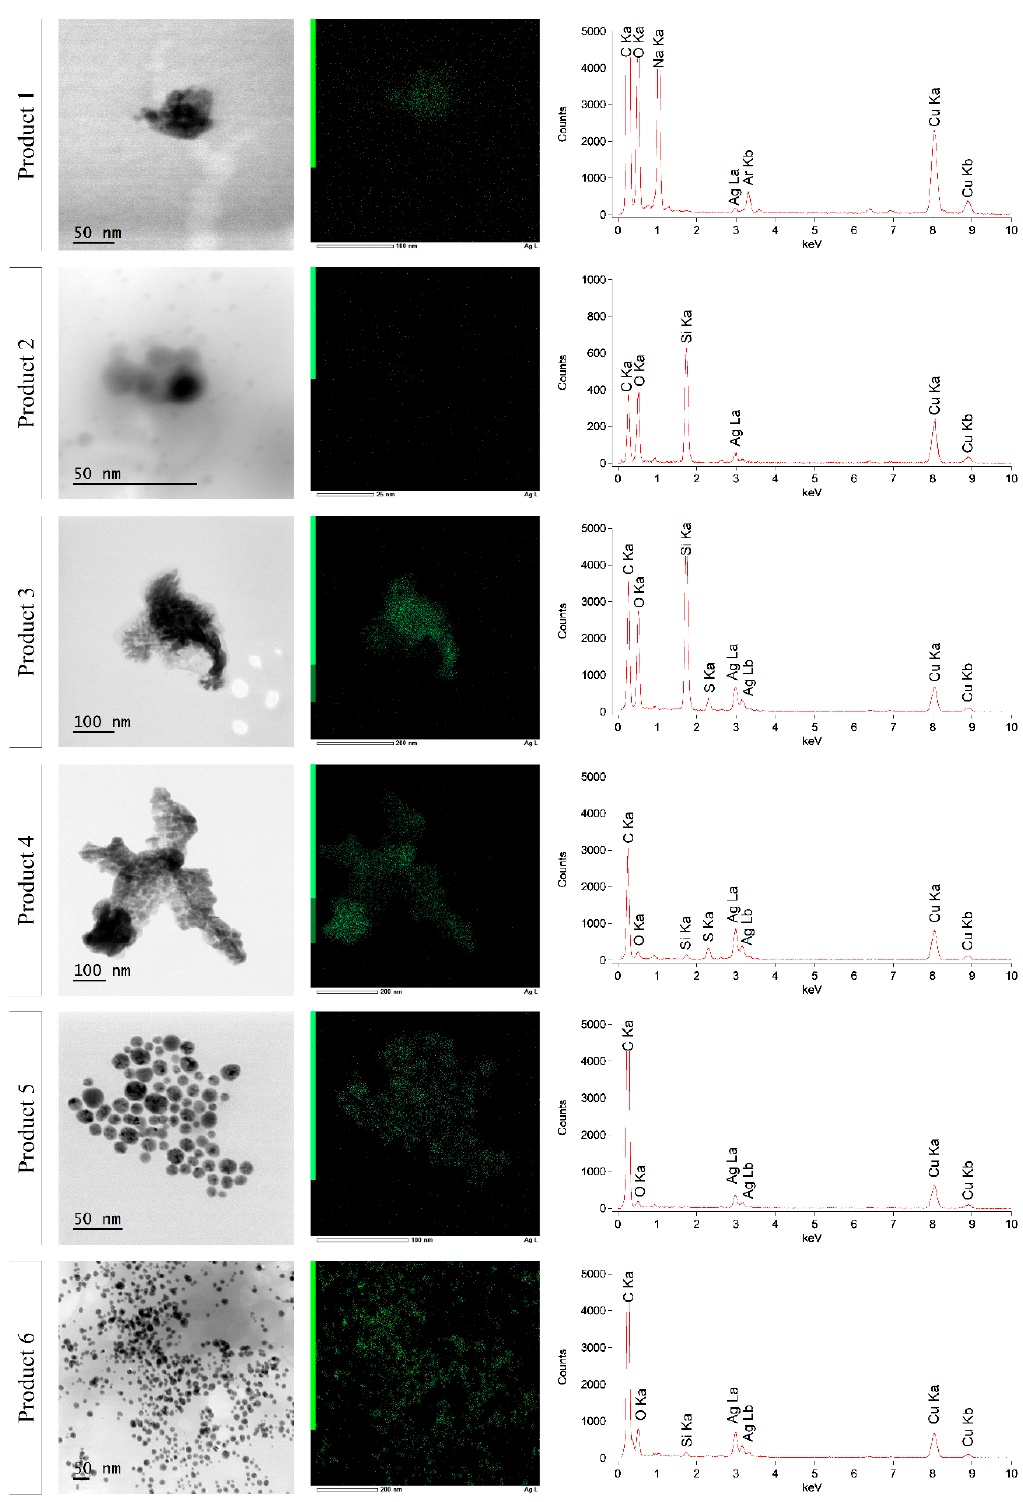
Figure 8. STEM ‐ EDX results of products 1, 2, 3, 4, 5, and 6. Batch 1 is represented for products 5 and 6.